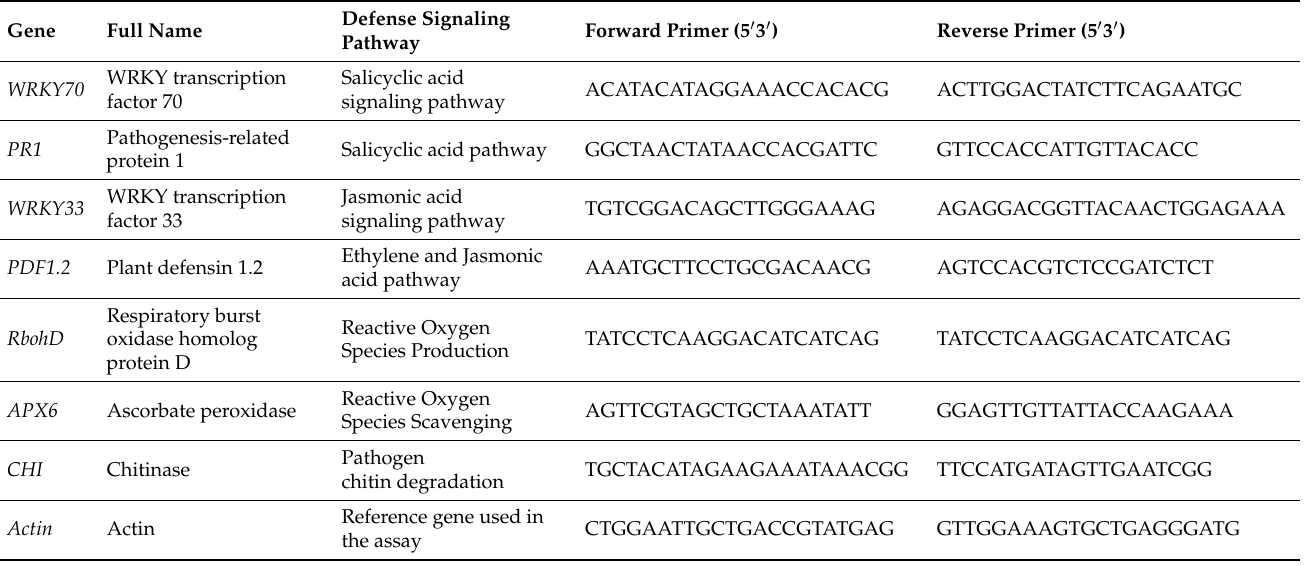
Table 1. List of selected defense-related genes in canola used in gene expression analyses and the primer pairs used for each